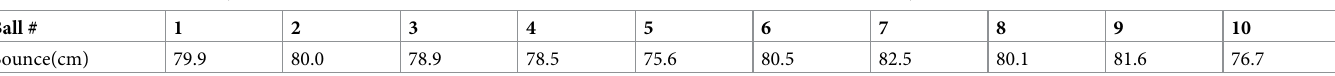
Table 7. Real-life data set-2 (Golf ball first bounces of 10 balls from the distance of 1-meter measurement in cm). Ball # 1 2